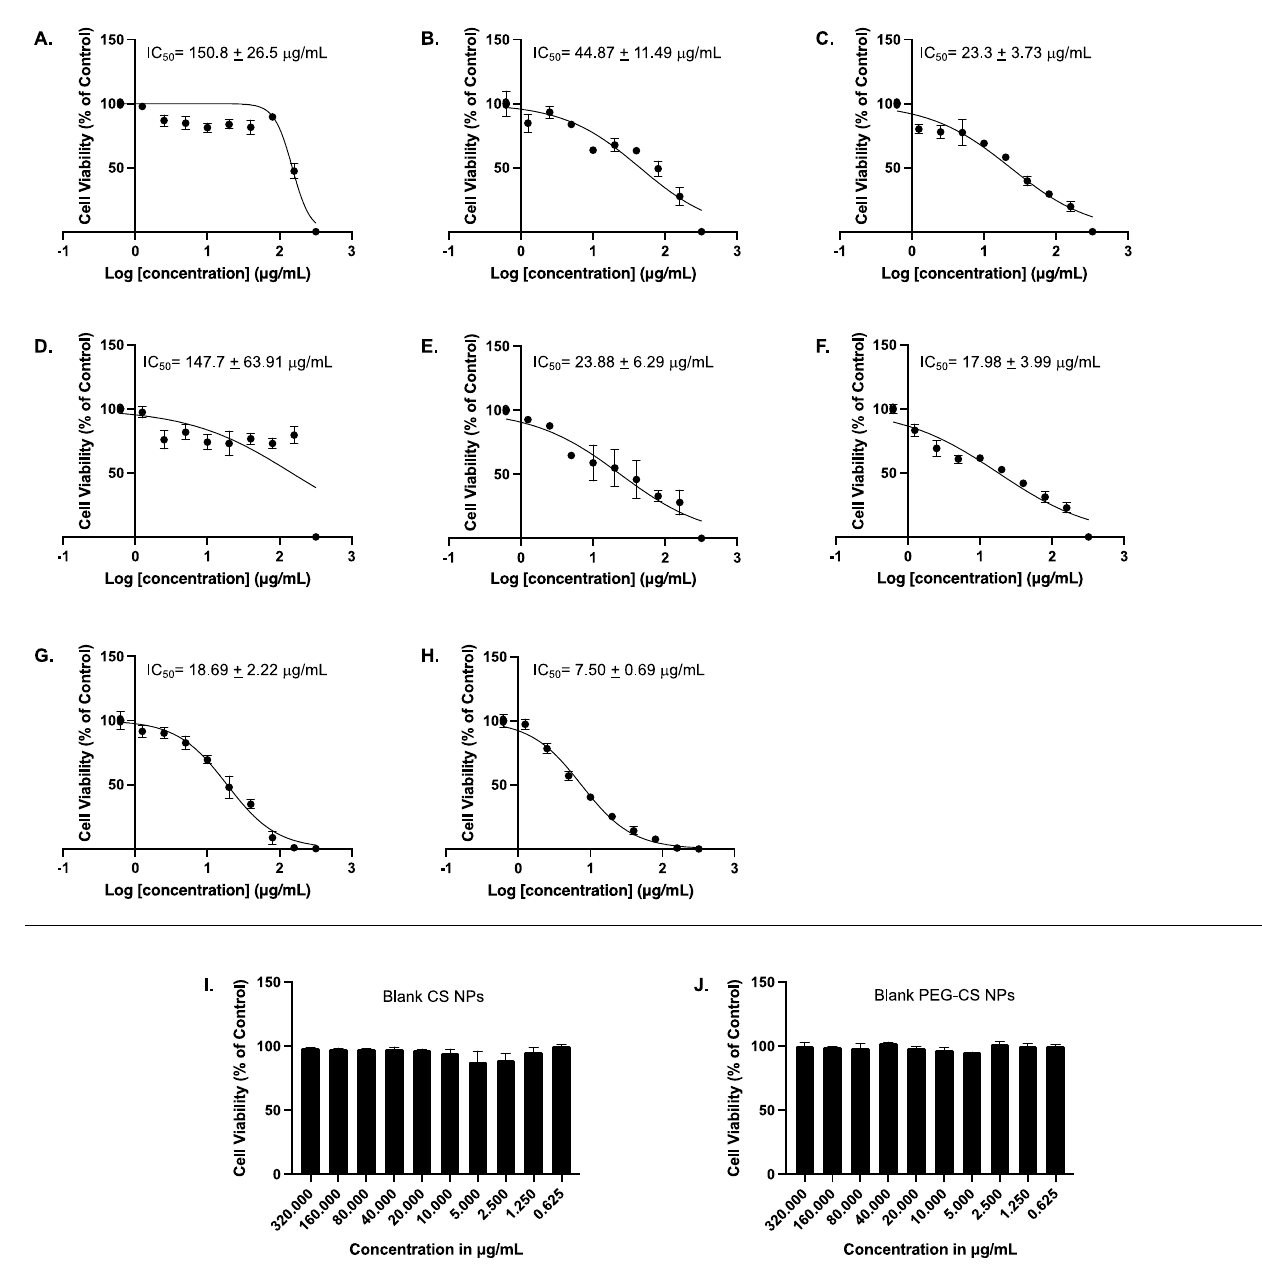
Figure 5. Concentration-dependent effects of the tested compounds on cellular viability of MCF-7 cells. MCF-7 cells were treated with 10 increasing concentrations (0.625, 1.25, 2.5, 5, 10, 20, 40, 80, 160, and 320 µg/mL) of AA ( A ), AA/CS NPs ( B ), AA/PEG-CS NPs ( C ), OX ( D ), OX/CS NPs ( E ), OX/PEG-CS NPs ( F ), AA-OX/CS NPs ( G ), AA-OX/PEG-CS NPs ( H ), blank CS NPs ( I ), or blank PEG-